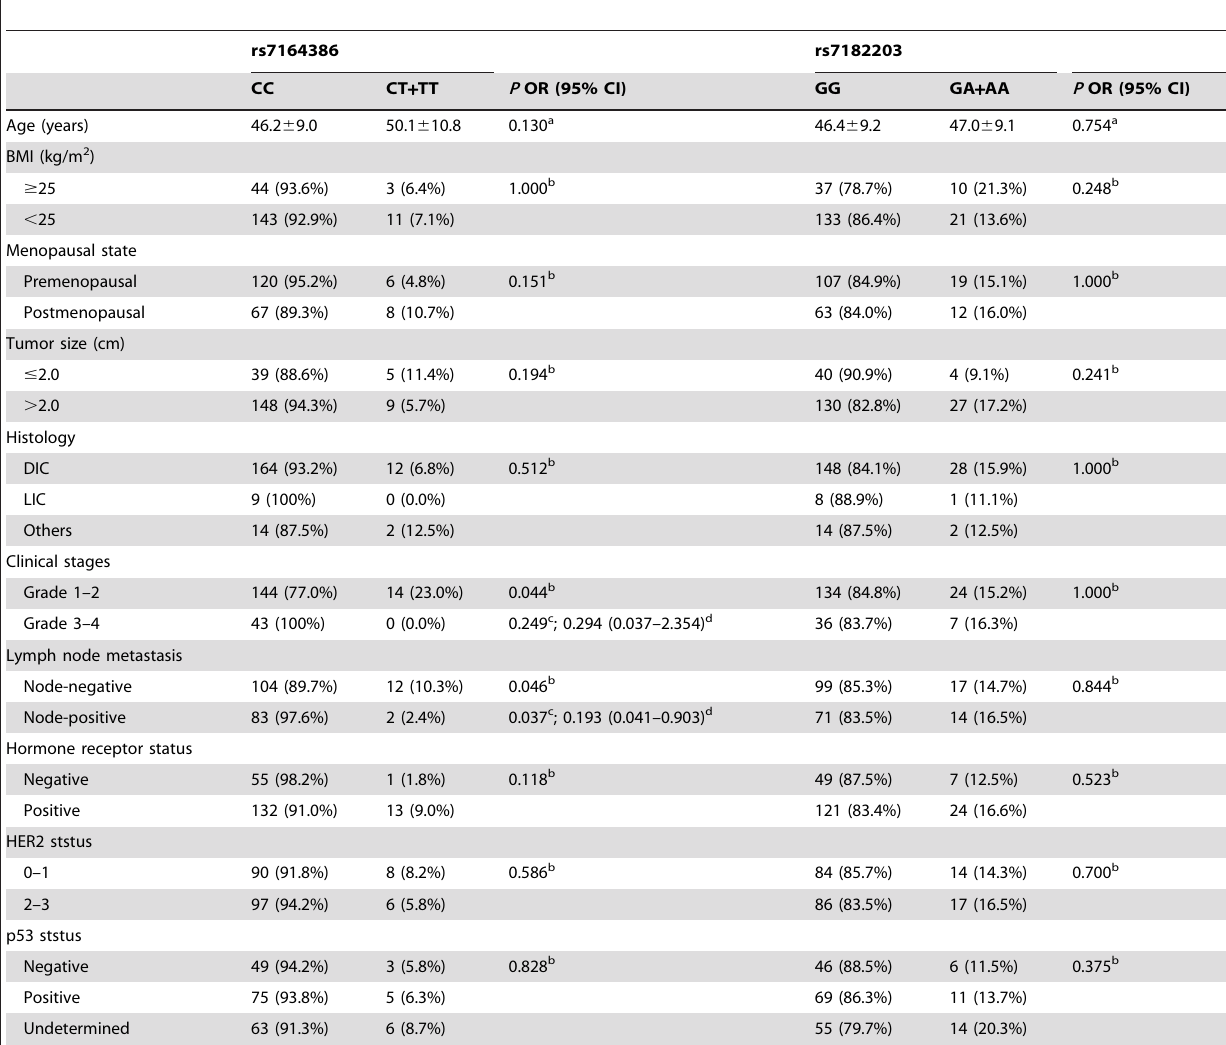
Table 5. Correlations of clinicopathological parameters and HDC polymorphisms in patients with breast